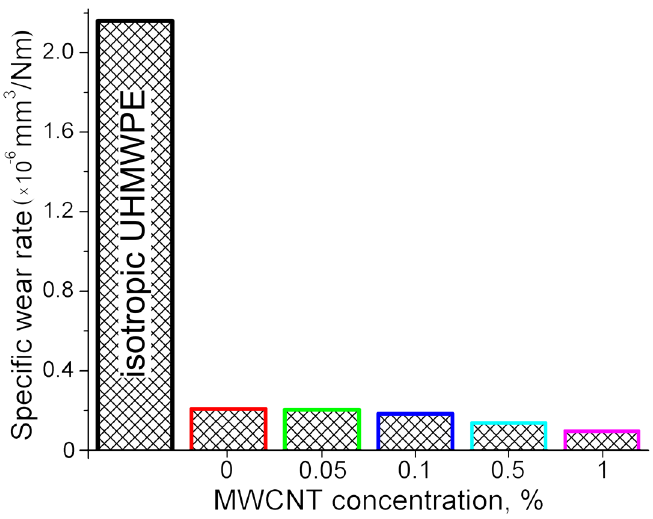
Figure 6. Specific wear rate for the isotropic UHMWPE and the oriented UHMWPE films with various concentrations of FMWCNTs.